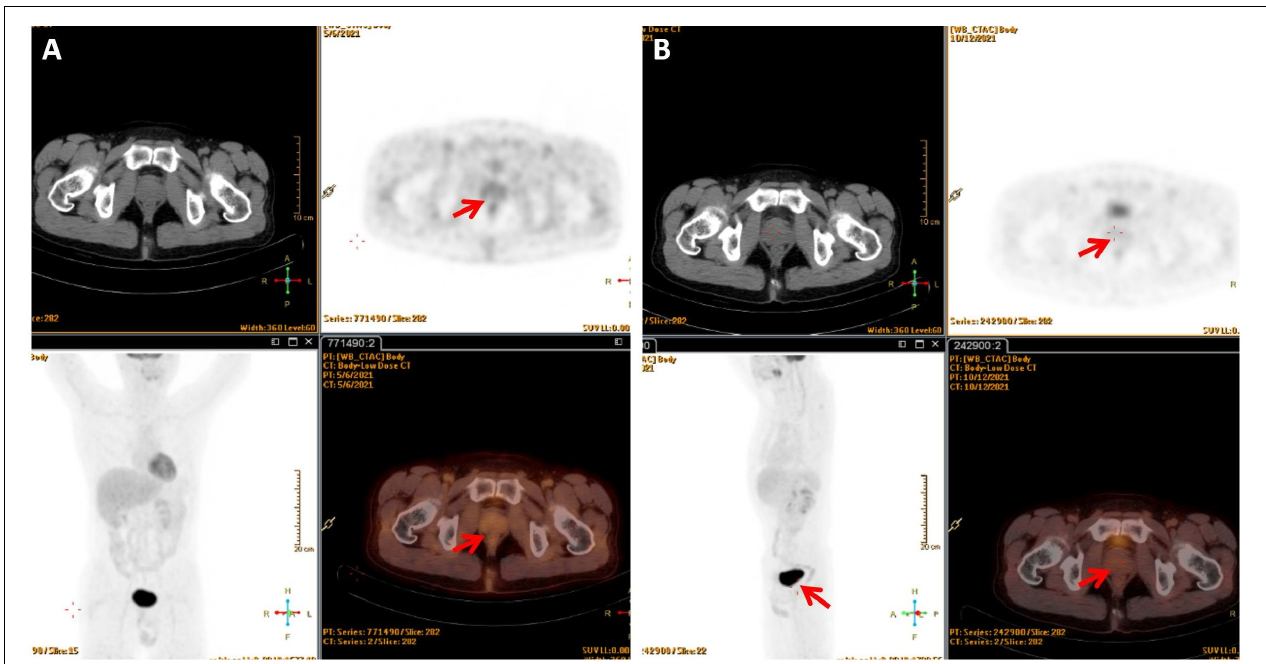
FIGURE 3 | 18F-FDG PET/CT showed no abnormal increased glucose metabolism in the lesion (A) 3 months after radiotherapy; (B) 6 months after